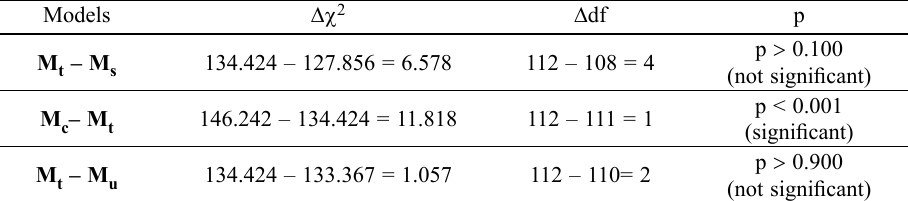
Table 5. c 2 : Chi-square difference between